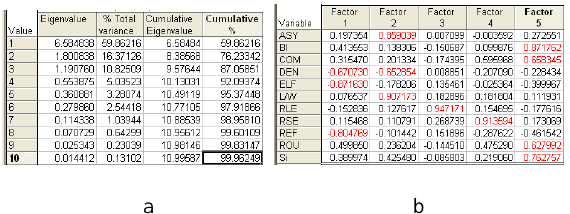
Table 4. a) The values of the principal components and